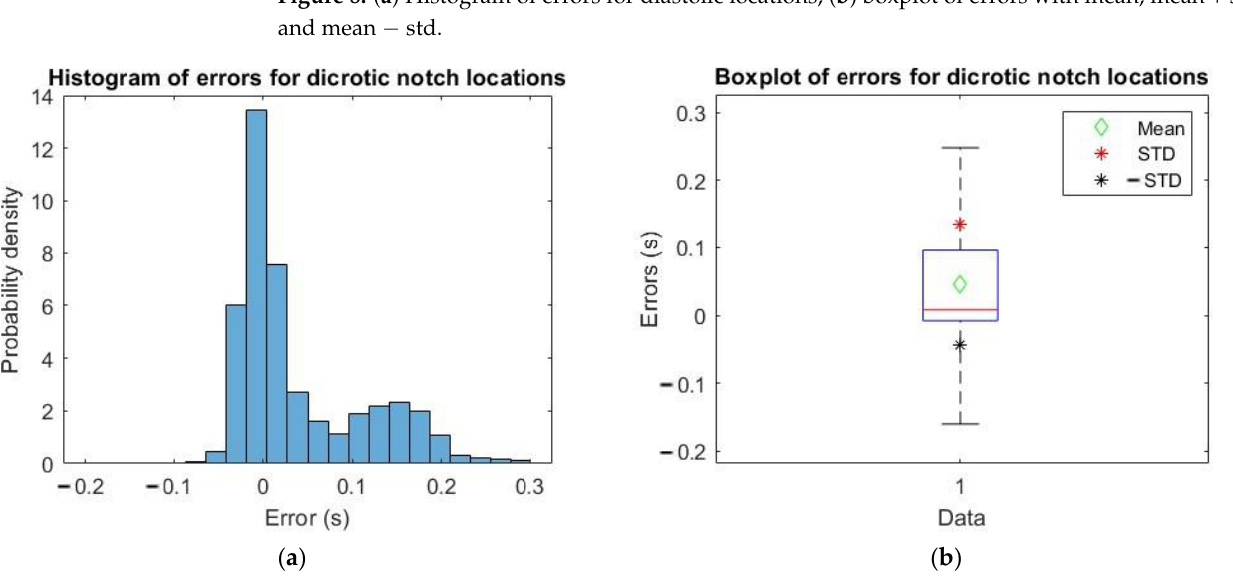
Figure 9. ( a ) Histogram of errors for dicrotic notch locations; ( b ) boxplot of errors with mean, mean + std and mean-std. std and mean − std.